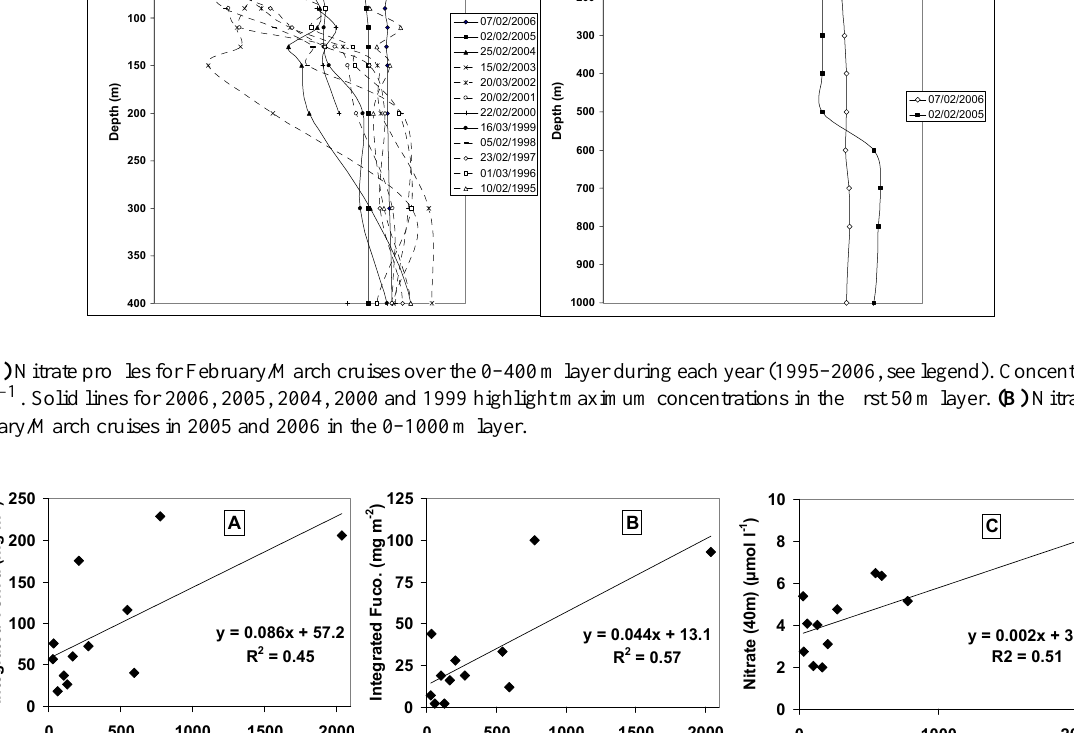
y = 0.086x + 57.2 R 2 = 0.45